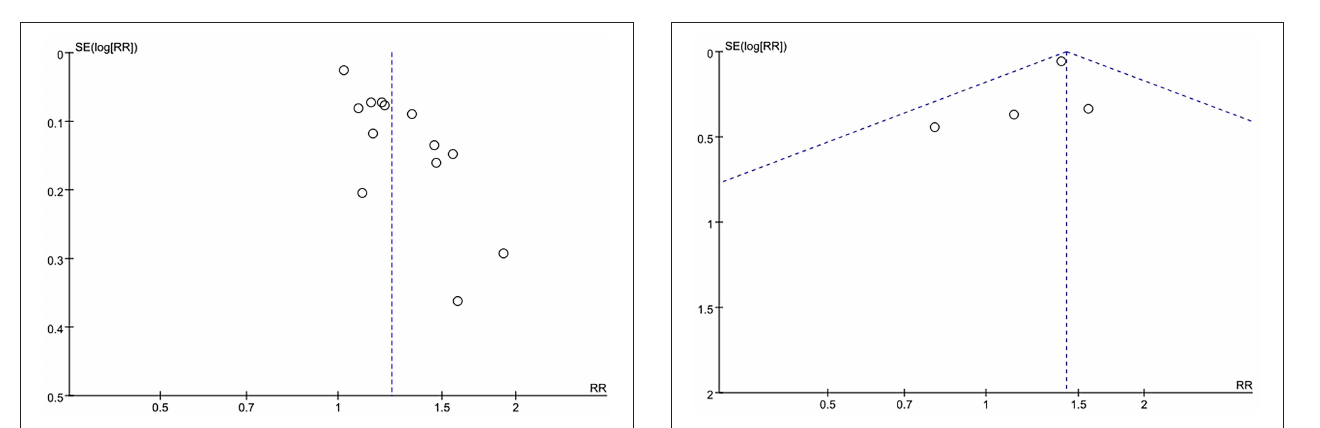
FIGURE 7 | A Funnel plot of the current smoking and non-smoking groups.